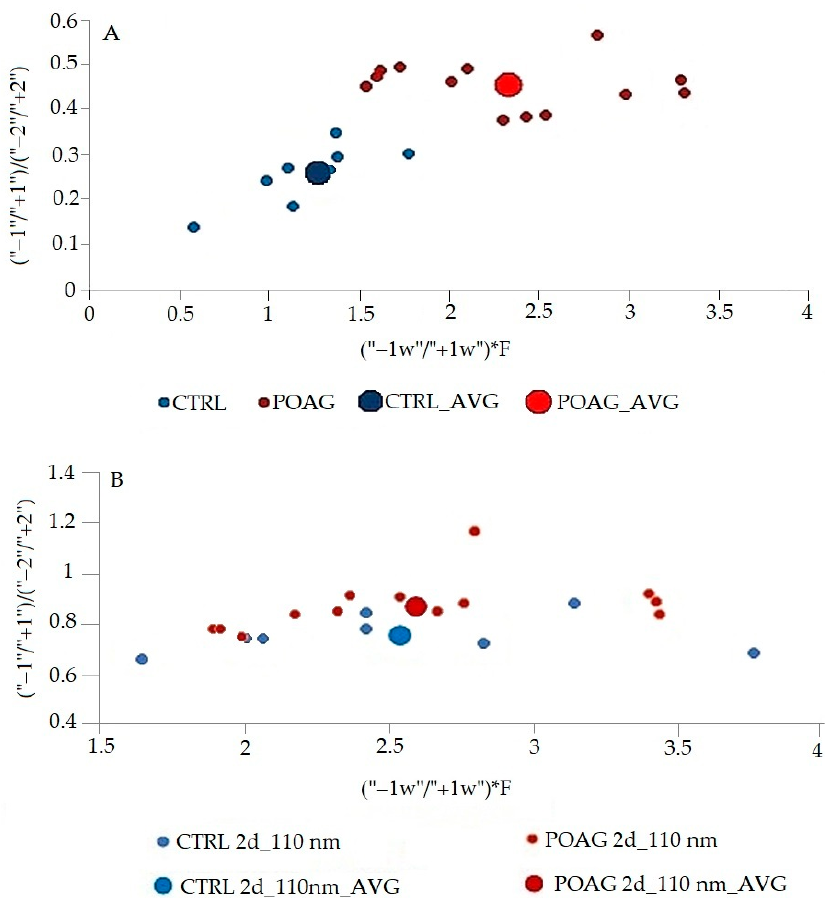
Figure 6. Comparison of the mathematical processing of two different ways of using 3D derivative fluorescence analysis to distinguish between glaucoma patients (POAG) and healthy subjects with normal intraocular pressure (CTRL). Graphical differentiation between tear fluid of glaucoma patients and healthy subjects with normal intraocular pressure. ( A ). Mathematically processed second derivative synchronous profile (SP) of glaucoma patients and healthy subjects tear fluid. CTRL_AVG. ( B ). Mathematically processed second derivative synchronous spectrum Δλ = 110 nm of glaucoma patients and healthy subjects tear fluid. The second derivative of both synchronous profile and synchronous spectrum Δλ = 110 nm were mathematically processed, and the result was plotted on a graph. The ratio (“1”/“+1”)/(“ − 2”/“+2”) expresses the relationship between the two fluorescence peaks and characterizes the whole synchronous profile. In contrast, the ratio (“ − 1w”/“+1w”) represents only the first fluorescence center where the differences between the CTRL and POAG groups were greatest. The large point represents the average (AVG) of the results in the group of POAG and CTRL. The same patients (POAG) and healthy subjects (CTRL) were used for the analyses of the synchronous profile and Δλ = 110 nm synchronous spectrum.